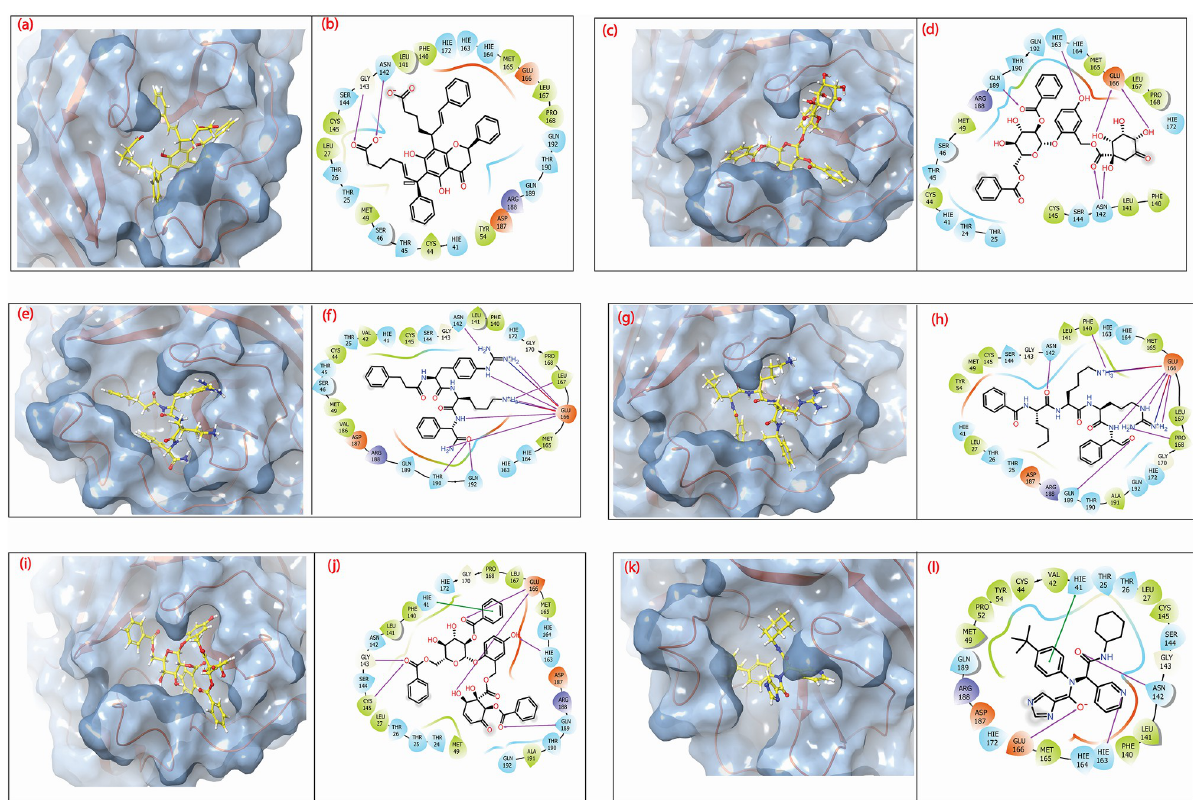
Fig 5. 3D and 2D interaction profiles for SARS-CoV-2 M pro - compounds (a-b) M pro -CHEMBL1940602 (c-d) M pro -CHEMBL2036486 (e-f) M pro - CHEMBL3628485 (g-h) M pro -CHEMBL200972 (i-j) M pro -CHEMBL2036488, and (k-l) M pro -X77 (control).